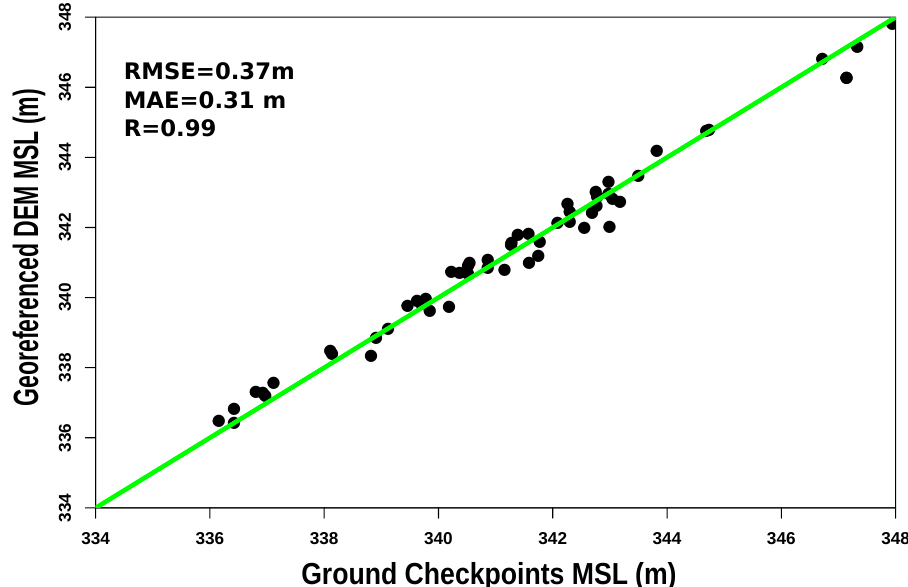
Figure 8. Ground checkpoints vs. Structure from Motion DEM elevations at 60 co-located points within the study area. The locations are illustrated in blue in Figure 7A. The green line represents a perfect correlation between the checkpoints and